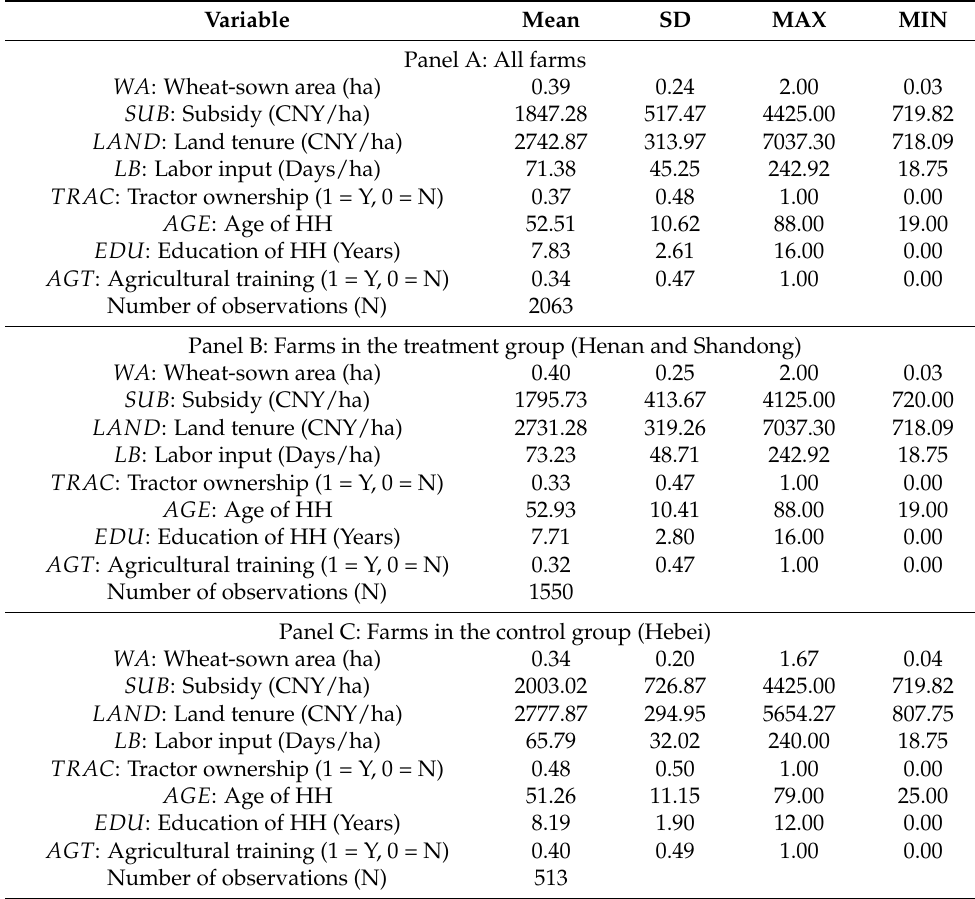
Table 1. Summary statistics of